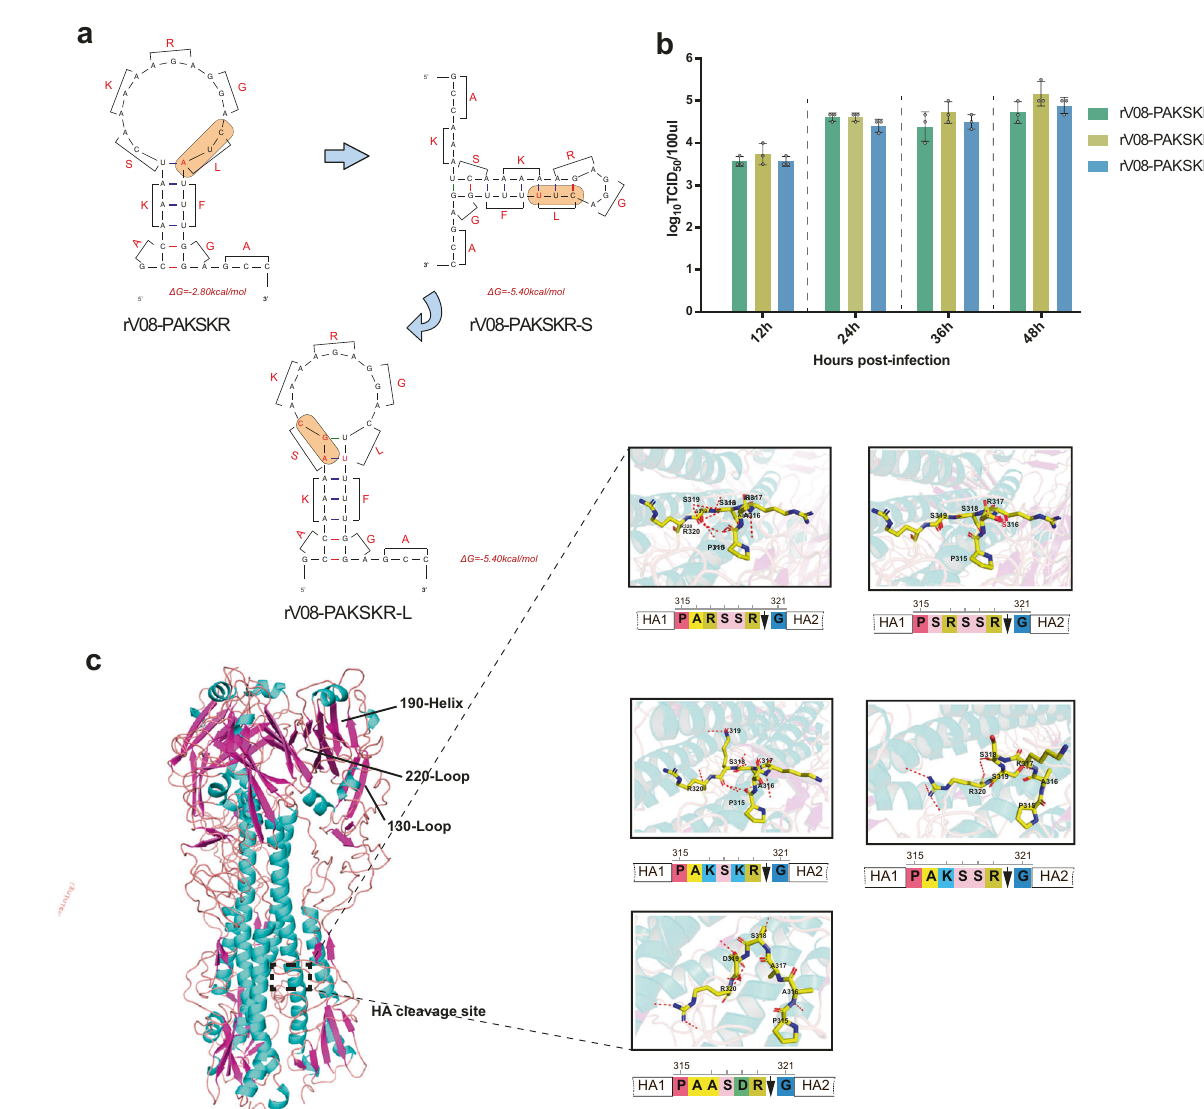
Fig. 5 The structures of the tribasic HA cleavage sites and growth property of tribasic H9N2 viruses. a The predicted RNA secondary structures of tribasic HA cleavage sites and amino acids corresponding to each codon are shown. The Quickfold program (http://unafold.rna.albany.edu/?qDINAMelt/ Quickfold) and RNAfold program from the ViennaRNA Web Services (http://rna.tbi.univie.ac.at/) and the ViennaRNA package were used to predict RNA sequences of the cleavage site regions of the HA genes. b Growth curves after inoculation of each virus at a multiplicity of infection of 0.001 into MDCK cell. Each point on the curve is the mean ± standard deviation from three independent experiments. c Three-dimensional (3D) structural analysis of amino acids at the HA cleavage site. A side view of the HA trimer structure of in fl uenza A virus based on the uncleaved H3 monomer (protein Data Bank ID 4BSE) as a template. The corresponding amino acids to a 3D structure of the HA protein containing different cleavage motifs were mapped using MacPymol